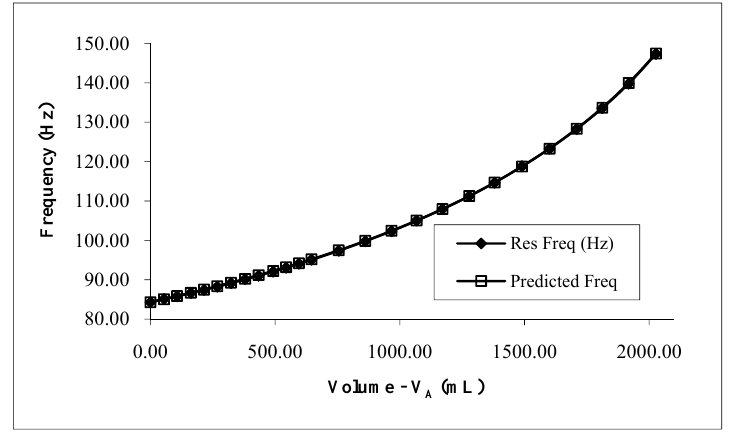
− V ) using Helmholtz P A